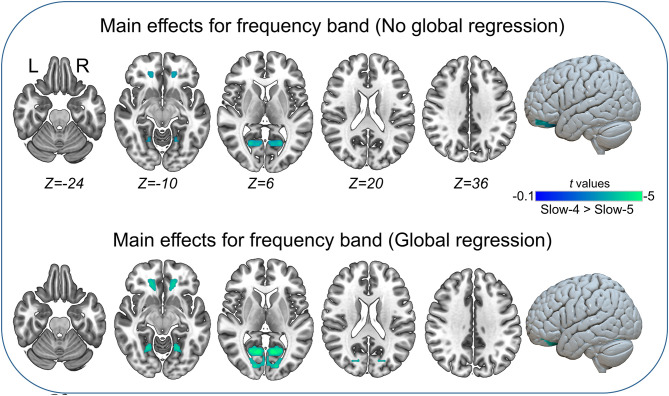
Main effects for frequency band. Only significantly reduced VMHC was found (cold colorbar, slow-4 < slow-5). The results were voxel-wise p <0.001, cluster level p <0.05, family-wise error (FWE) cluster-level corrected. L, left; R, right.